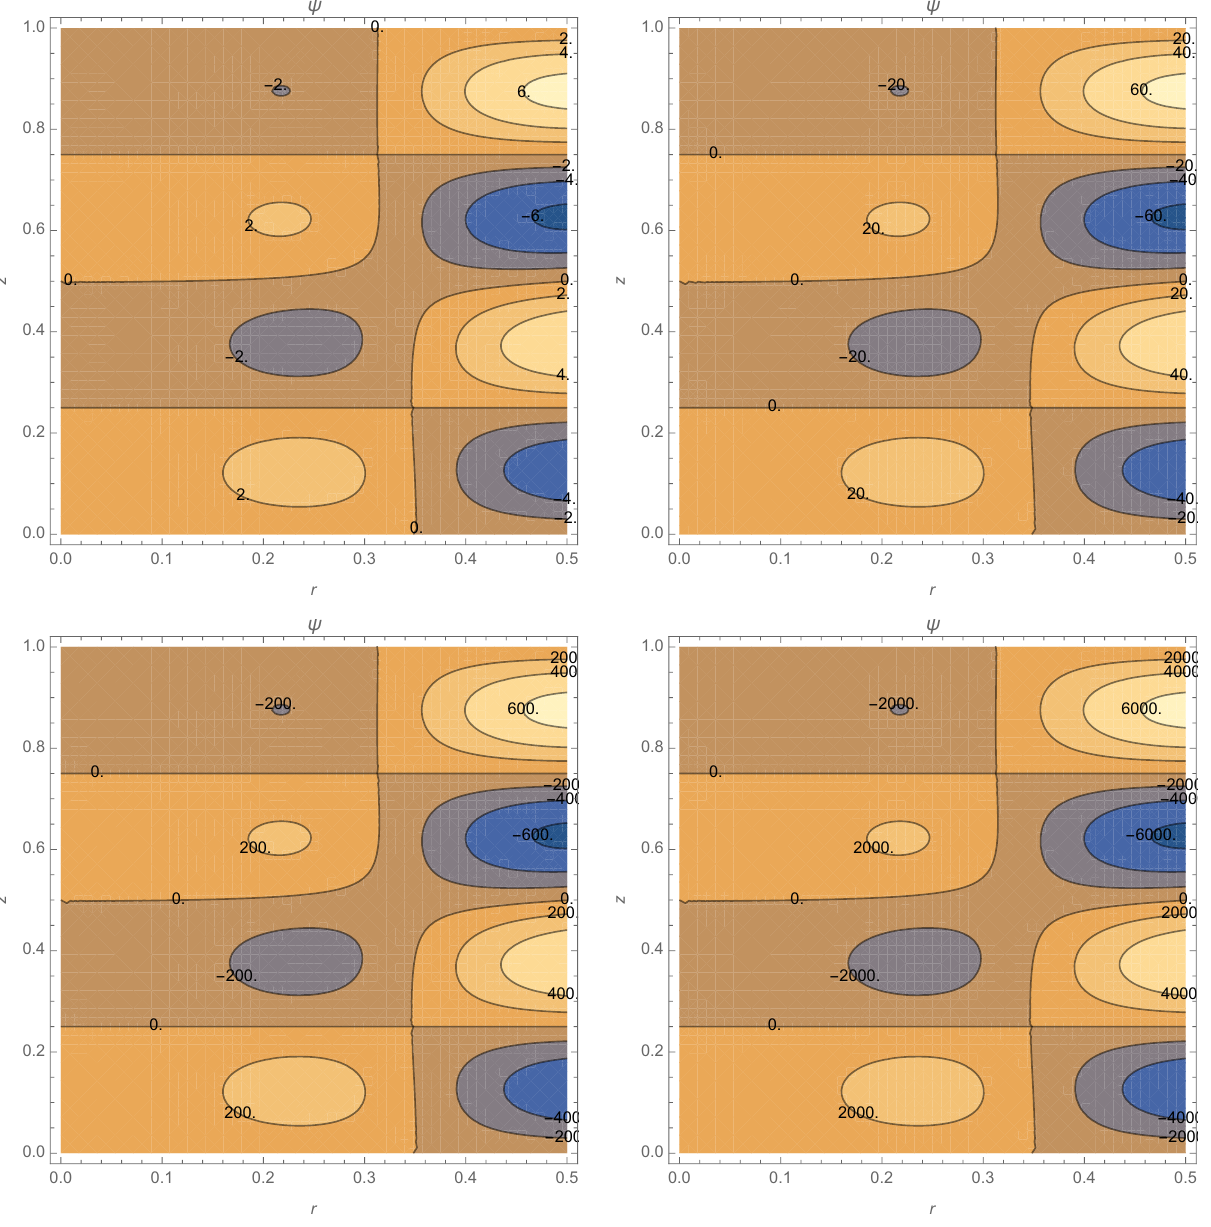
Figure 4. Dependence of the flow function ψ on α in the case with magnet: α = 0.001 ( top left panel ), 0.01 ( top right panel ) 0.1 ( bottom left panel ), and 1 ( bottom right panel ). See text for